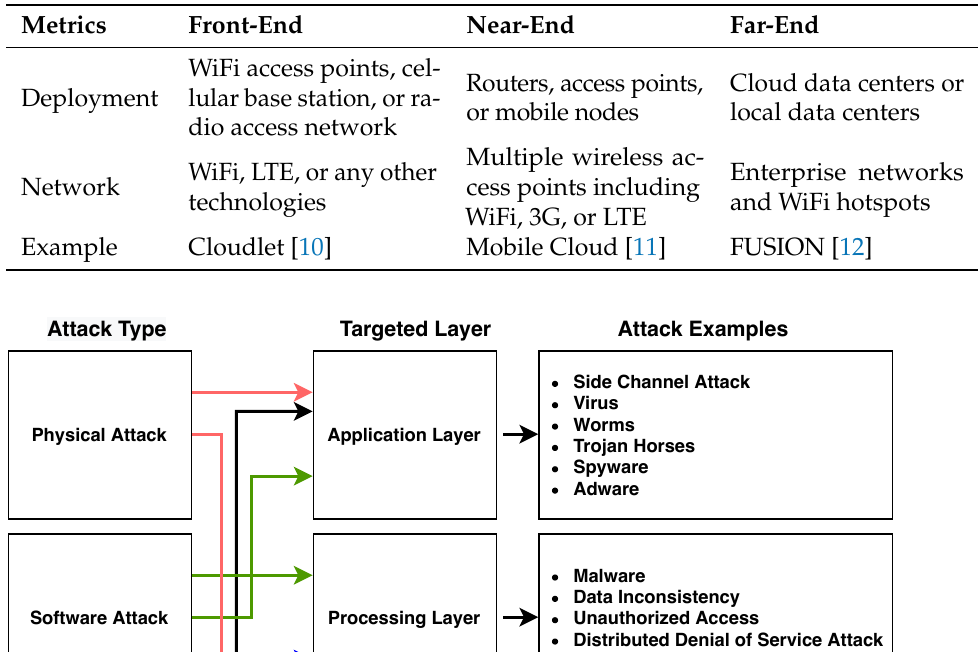
Table 1. Comparison of Edge Computing Ends.